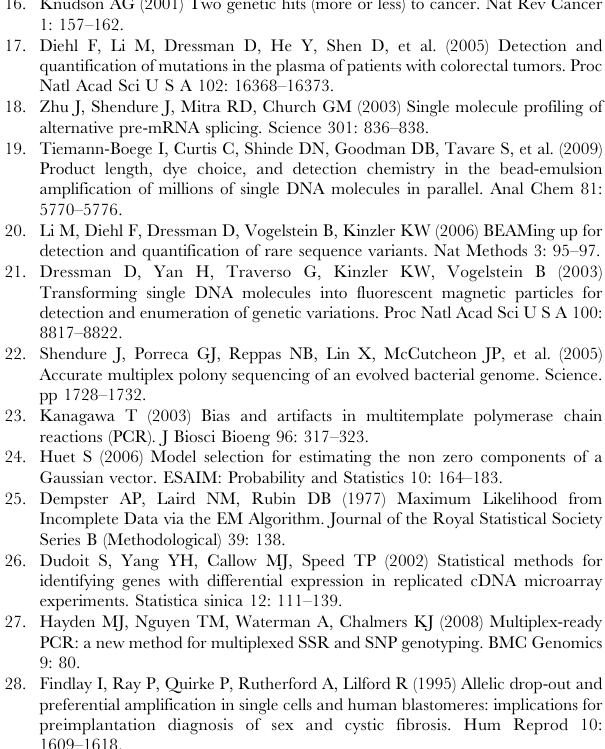
Table S2 Mutation rate of 4 different commercially available Table S3 Chimera formation in different product